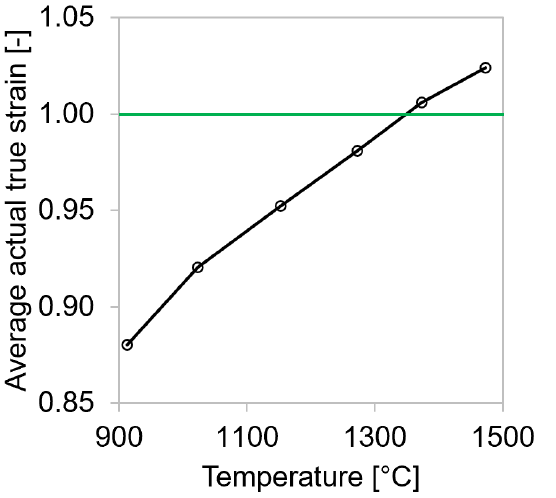
Figure A1. Increase in the average actual true strain with rising deformation temperature of single-hit compression tests with 25 s holding time before deformation and 0.01 s − 1 strain rate at 913–1473 K for MA steel grades S1–S5.